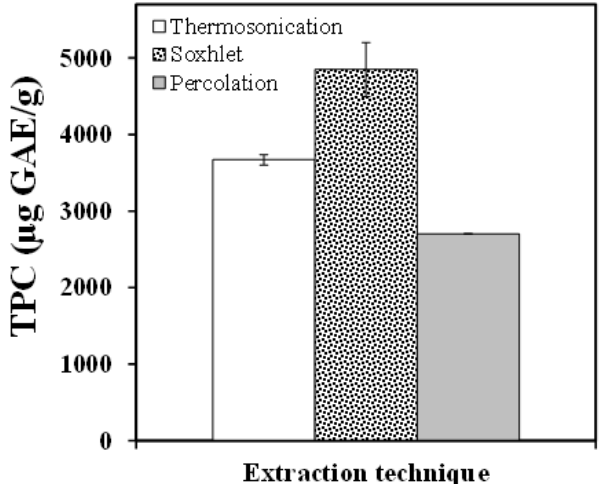
Figure 6. TPC yield acquired for each extraction technique.